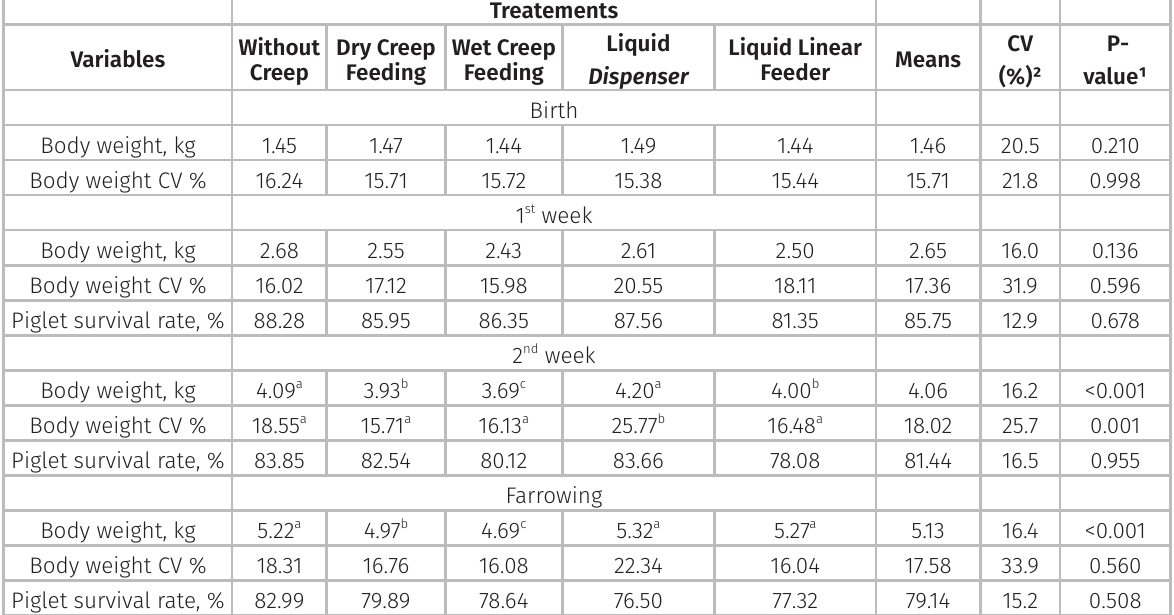
Table II. Body weight (BW), piglet survival rate (%) and coefficient of variation (CV) of piglets under different feed